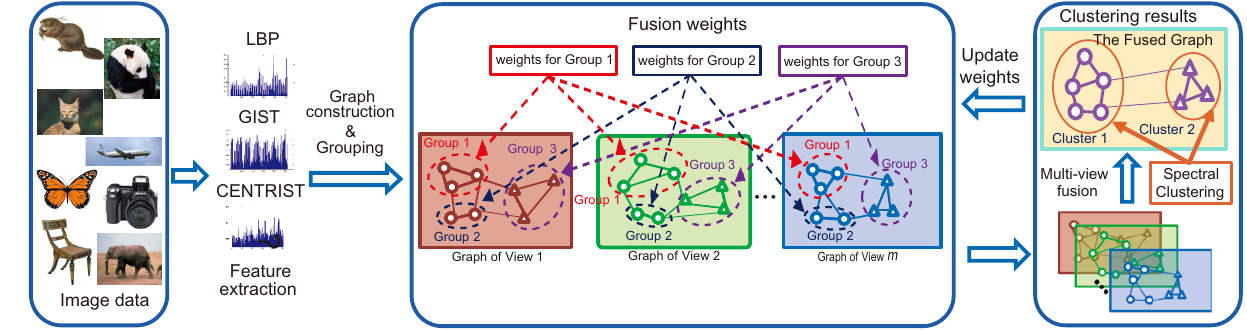
Fig. 7 The framework of group-aware multi-view fusion approach [62]